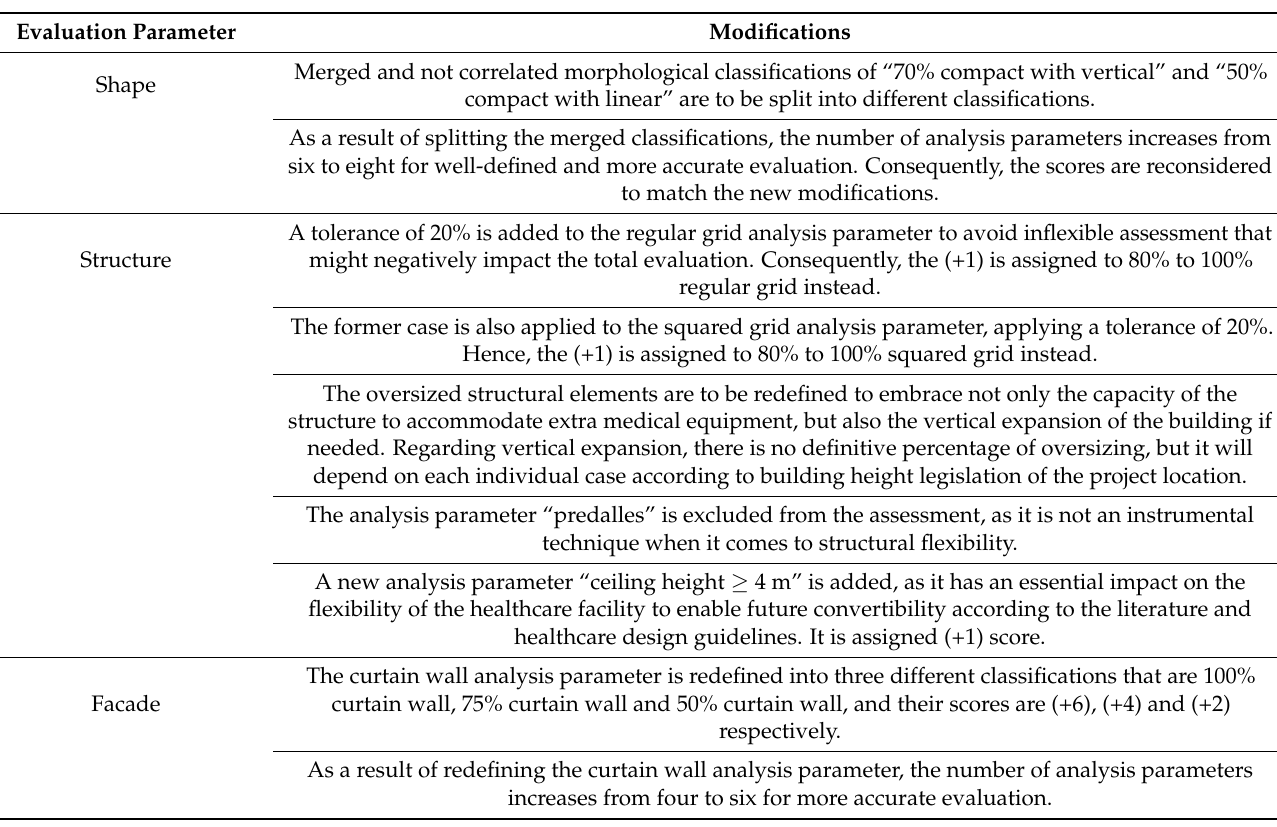
Table 8. Proposed modifications for each evaluation